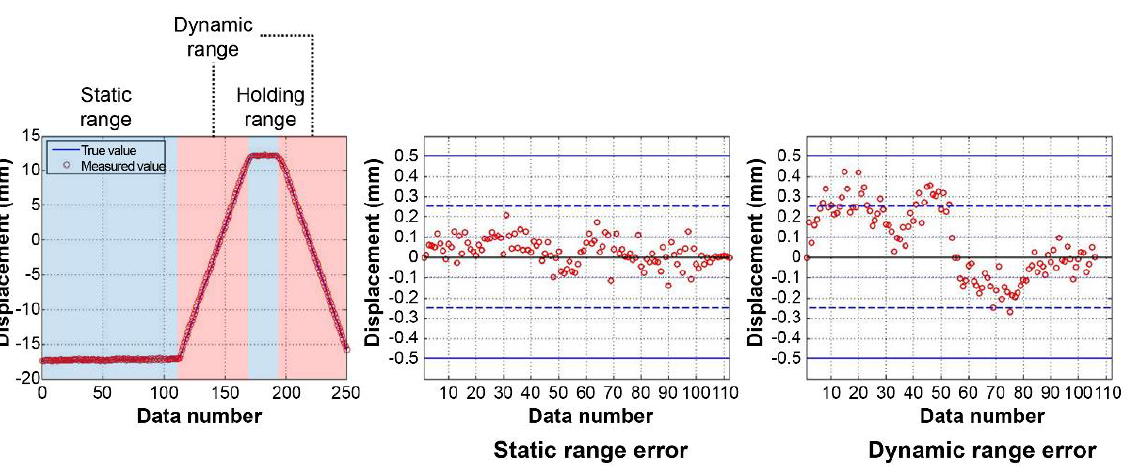
Figure 6. Y -axis movement signal comparison (stage control vs. measured displacement) and errors of statics and dynamics ranges.